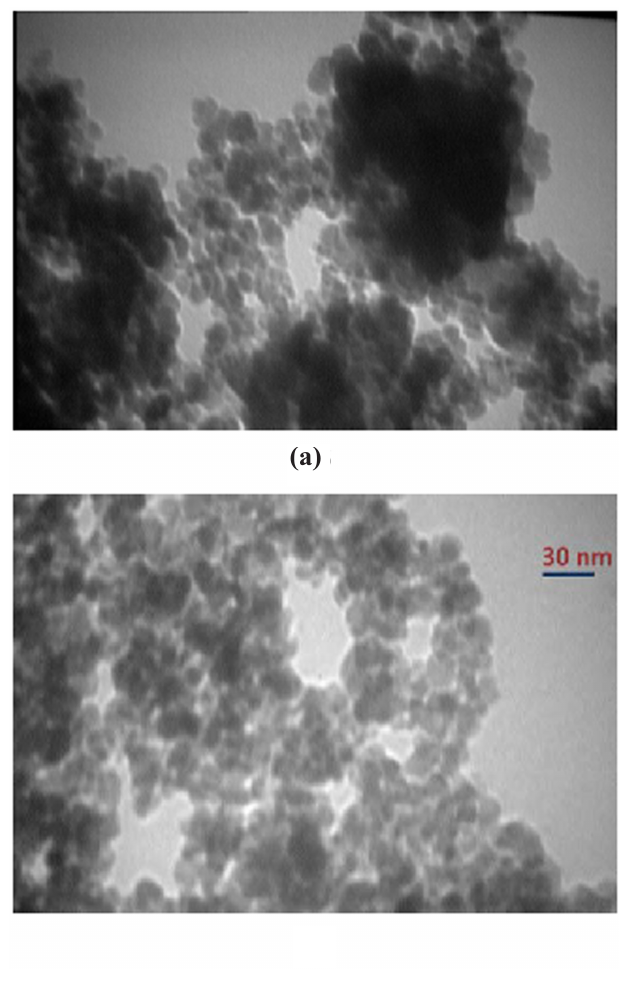
Fig. 3. TGA thermograms (N 2 atmosphere, scan rate of 10 ºC/min) of (a) MNPs; (b) Fe 3 O 4 @ZrO 2 ; (c) Fe 3 O 4 @ZrO 2 -SO 3 H. Fig. 4. The TEM images of (a) Fe 3 O 4 ; and (b) Fe 3 O 4 @ZrO 2 -SO 3 H.